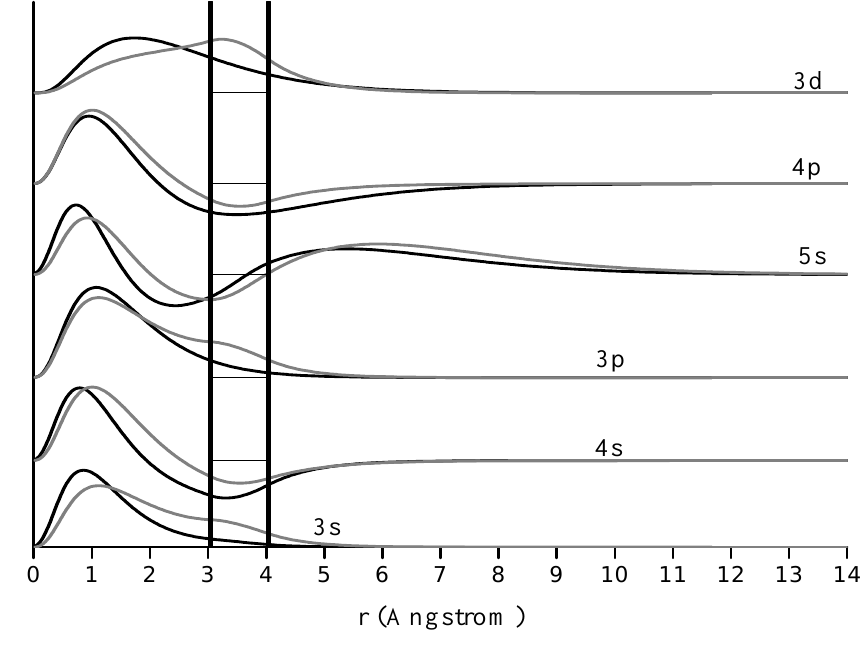
Figure 4. Radial wave functions rR of free and encapsulated magnesium for states n (cid:65) corresponding to those for hydrogen in Figure 3. Format is the same as in Figure 3 but vertical scales do not